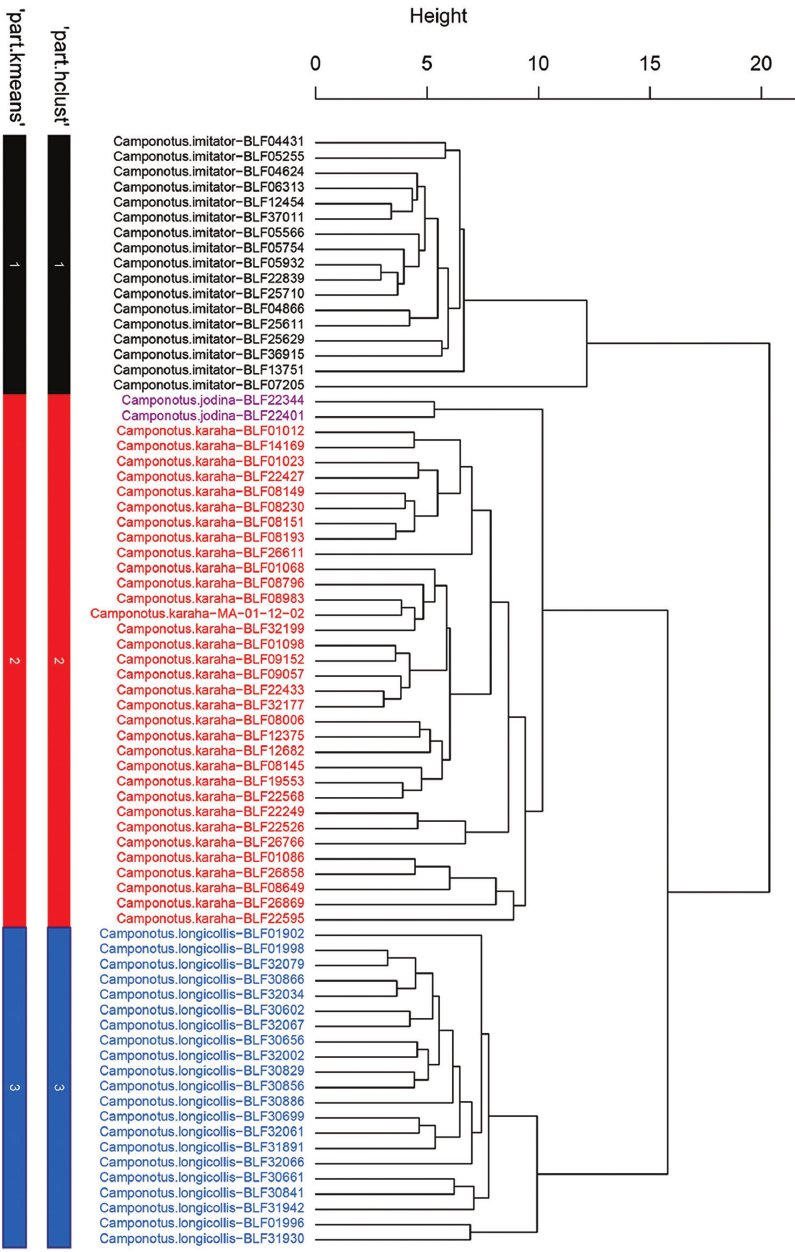
Figure 3. Dendrogram solution for the Malagasy Myrmopytia subgenus based on morphometric data. Labels include final species hypothesis followed by collection code separated by a hyphen. The color bars show partitioning yielded by two cluster methods ‘hclust’ and ‘kmeans’ via method PART. Color code: Camponotus imitator : black (cluster 1), C. jodina : purple (cluster 2), C. karaha : red (cluster 2), C. longicol- lis : blue (cluster 3